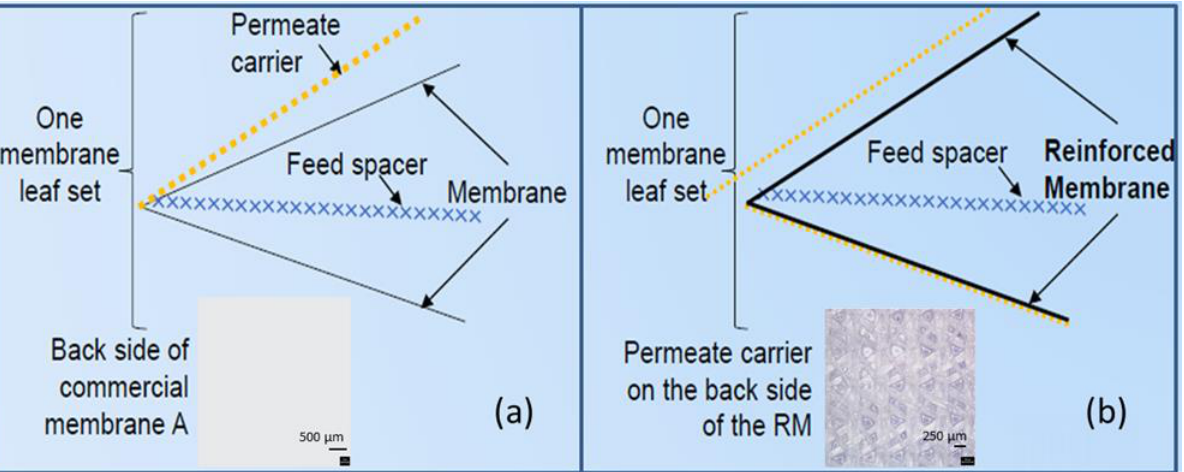
Figure 5. ( a ) Conventional spiral-wound module, which consists of 3 sheets, the feed spacer, the permeate carrier, and the membrane; ( b ) spiral-wound module with reinforced membrane consists of 2 sheets, i.e., the feed spacer and the reinforced membrane (combining the permeate carrier and membrane into a single sheet). The images of the backside of the membrane A and RM at magnifications of 200 X the objective.